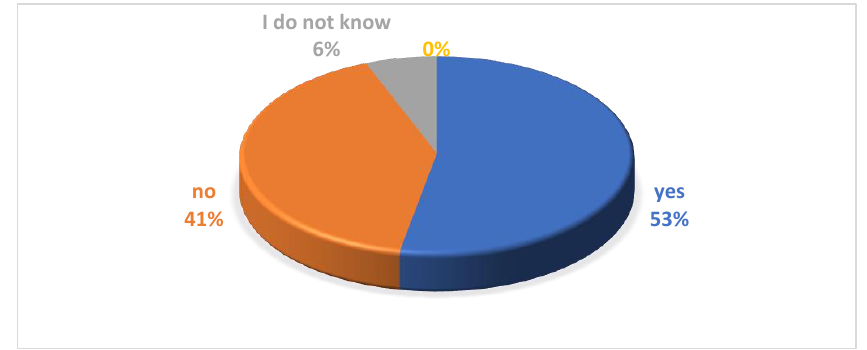
Figure 4. The development strategy of the commune in the area marked as indicated as the development of renewable energy.